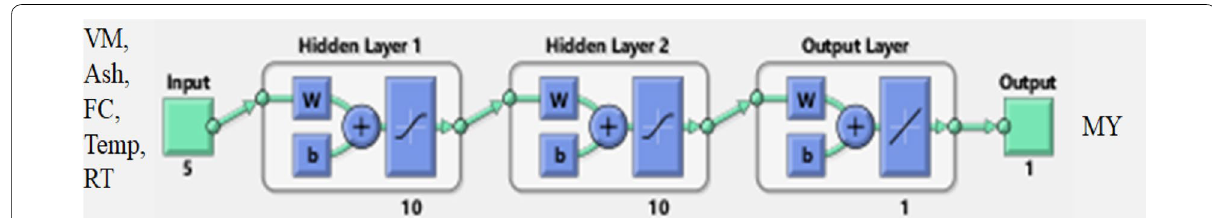
Fig. 6 Optimum MISO-ANN architecture for MY (5–10-10–1)